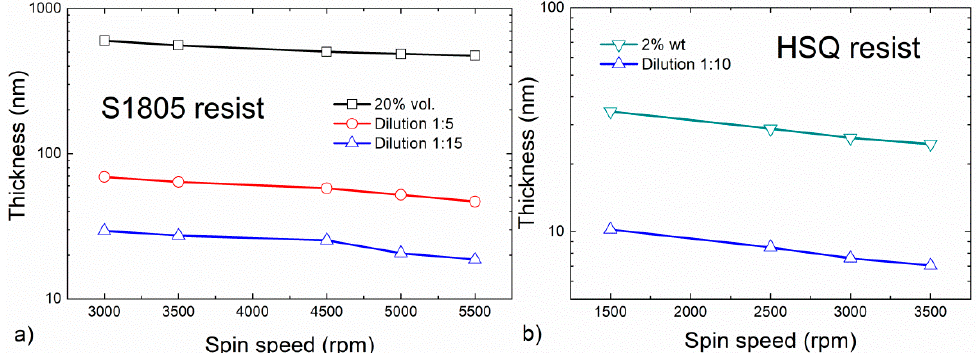
Figure 2. Layer thickness obtained for the different resist materials, Shipley S1805 ( a ) and HSQ ( b ), used along this work, for different dilutions.